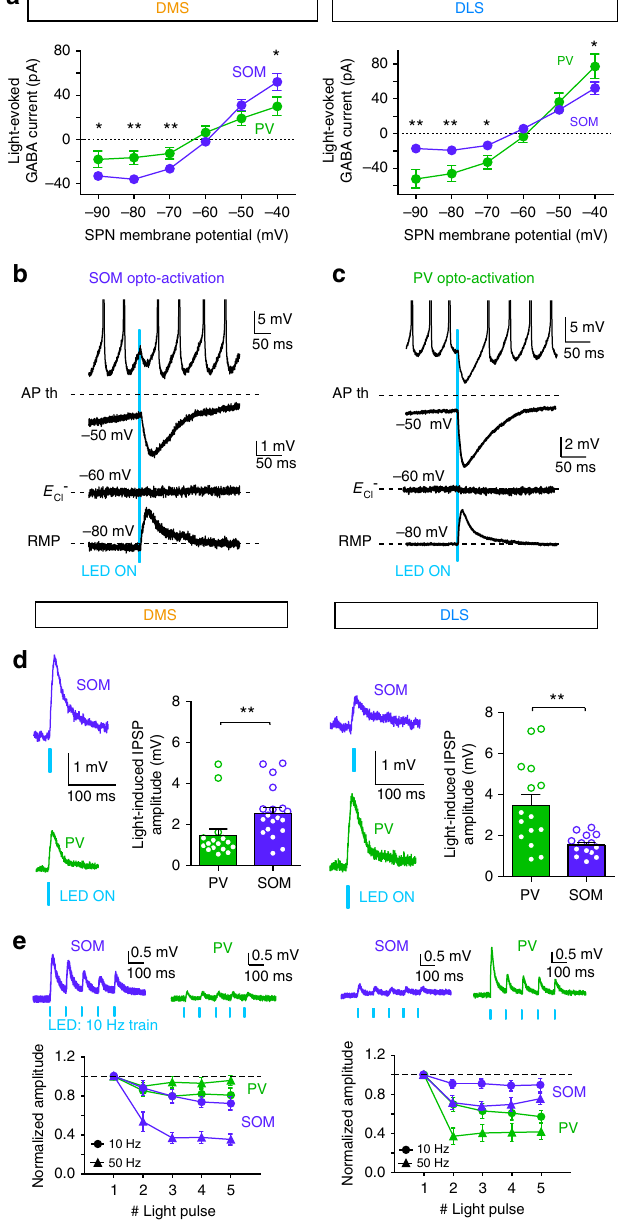
Fig. 10) or viral expression of AAV-Flex-ArchT-tdtomato in SOM-Cre and PV-Cre mice (Supplementary Fig. 11). In control conditions (no light), temporal summation was ef fi cient for high frequencies (at 50 and 100 Hz) but not for medium frequencies (10 and 20 Hz). Synaptic depression could even be recorded for low-frequency activation (5 Hz) (both in DMS and DLS, Fig. 7f and Supplementary Fig. 10). Selective opto-inhibition of SOM or PV cells decreased EPSP summation in SPNs in DMS and DLS, respectively (Fig. 7d – g): opto-inhibition of SOM cells induced a decrease of temporal summation in DMS ( F 1,120 = 2.05, p < 0.0001, n = 25 SPNs) but not in DLS ( F 1,80 = 0.11, p = 0.1536, n = 17 SPNs), while opto-inhibition of PV cells following a 50 Hz train led to a decrease in the temporal summation of EPSP amplitude in the DLS ( F 1,100 = 2.10, p < 0.0001, n = 24 SPNs) but not in DMS ( F 1,65 = 0.14, p = 0.1338, n = 14 SPNs) (Fig. 7d, e). Similar results were obtained for different frequencies (5, 10, 20 and 100 Hz) of cortical stimulations (Fig. 7f, g and Supplementary Fig. 10). In addition, similar results were obtained with expression